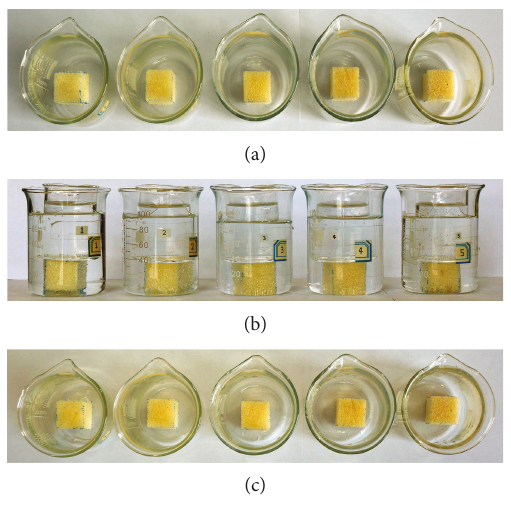
Figure 3: The photo of the water resistance test of RPUFs. In each subphoto, from the left to the right, the samples are F0, F1, F2, F4, and F5. Table 5: The percentage of the weight change of RPUFs with di ff erent loadings of LPCAs. RPUF